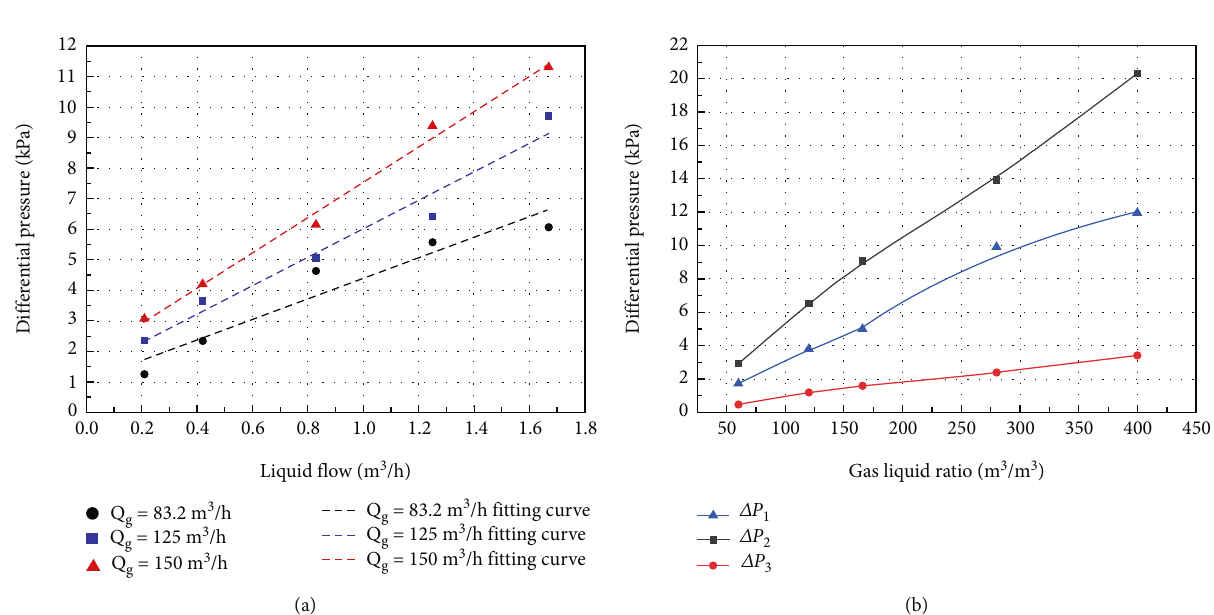
Figure 12: (a) Pressure drop variation at di ff erent liquid phase fl ow conditions; (b) di ff erential pressure variation curves at di ff erent cross- sudden contraction structure, Δ P sections ( Δ P 1